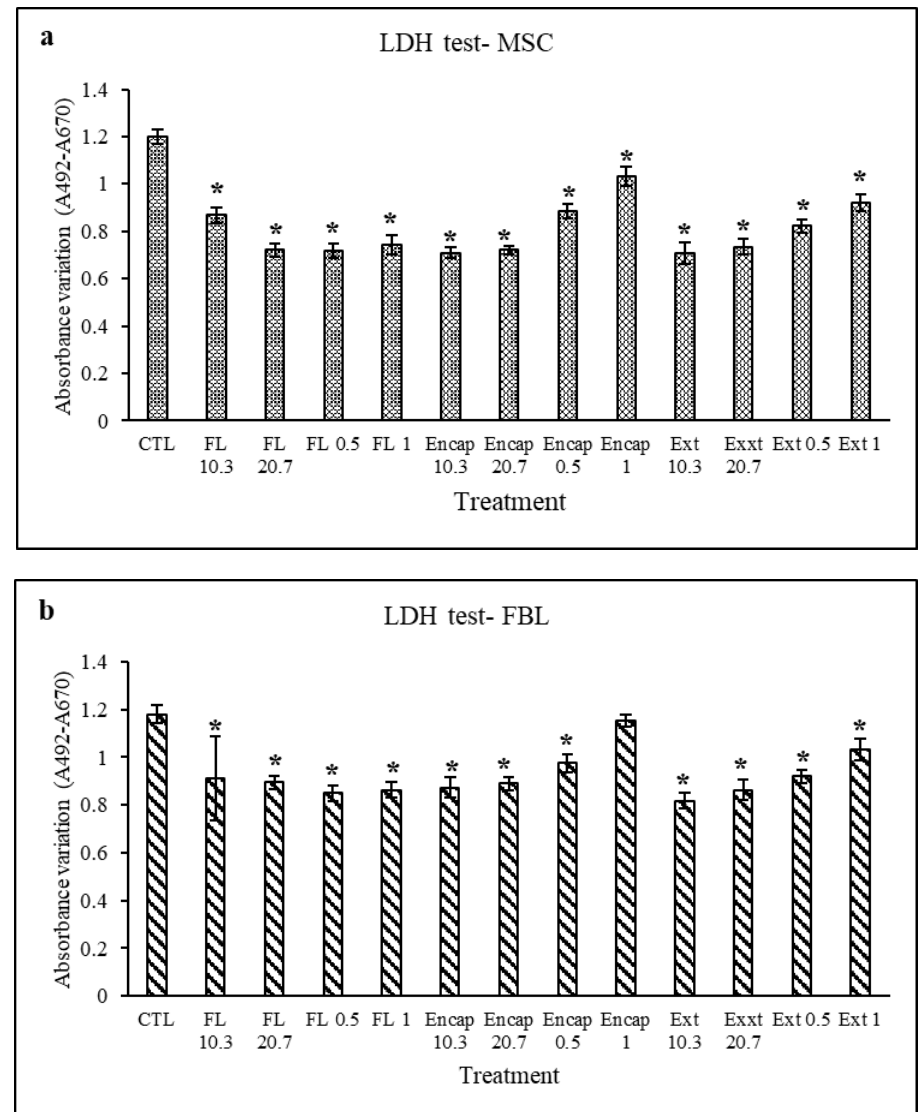
Figure 3. Lactate dehydrogenase activity of human cells: ( a )—mesenchymal (MSC) cells, ( b )—FBL cells under different treatments by: AC extract (Ext), unloaded nanoliposomes (FL) and AC-loaded nanoliposomes (Encap). CTL is control sample including unstimulated cells. Indexes of 1, 0.5, 20.7 and 10.3 represent the concentration of different treatments as 1 mg.mL −1 , 0.5 mg.mL −1 , 20.7 µg.mL −1 , and 10.4 µg.mL −1 respectively. * indicates there is significant statistical difference between different treatments and control sample ( p < 0.05). the results are mean of three replications ± SD.